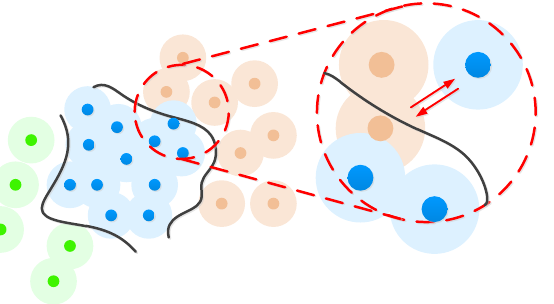
Figure 1. The boundary features are mixed by swapping the features of the boundary centroid and its farthest local